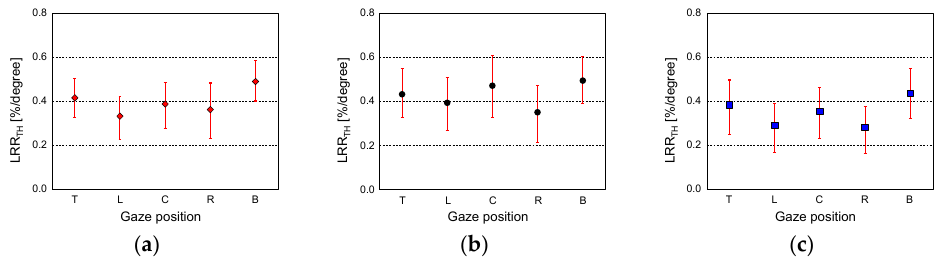
Figure 9. The resulting LRR TH s grouped by ( a ) AL50, ( b ) AL60, and ( c ) AL70 conditions. Table 2. The 95% CI ranges of the LRR TH s.